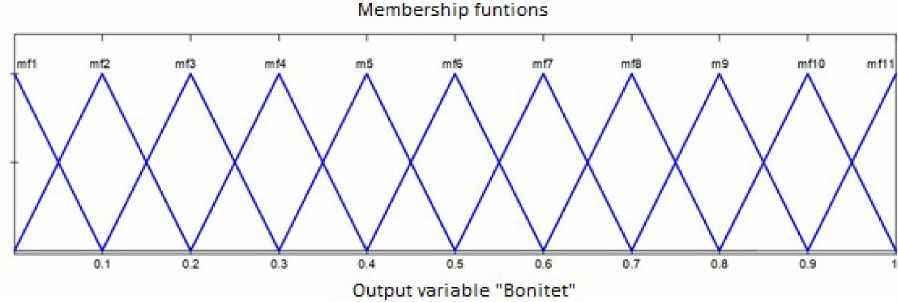
Figure 19. MFs of the output variable